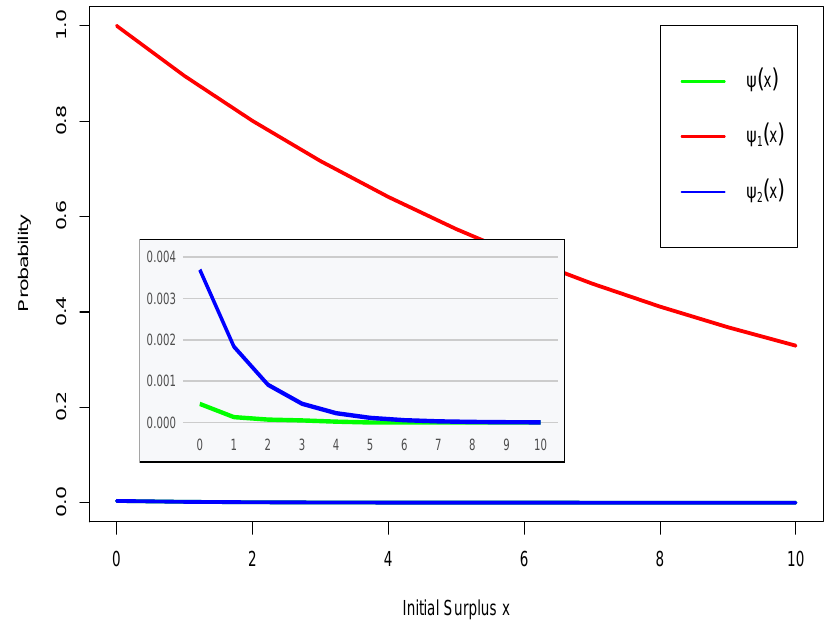
Figure 1. Ruin probability for model of Example